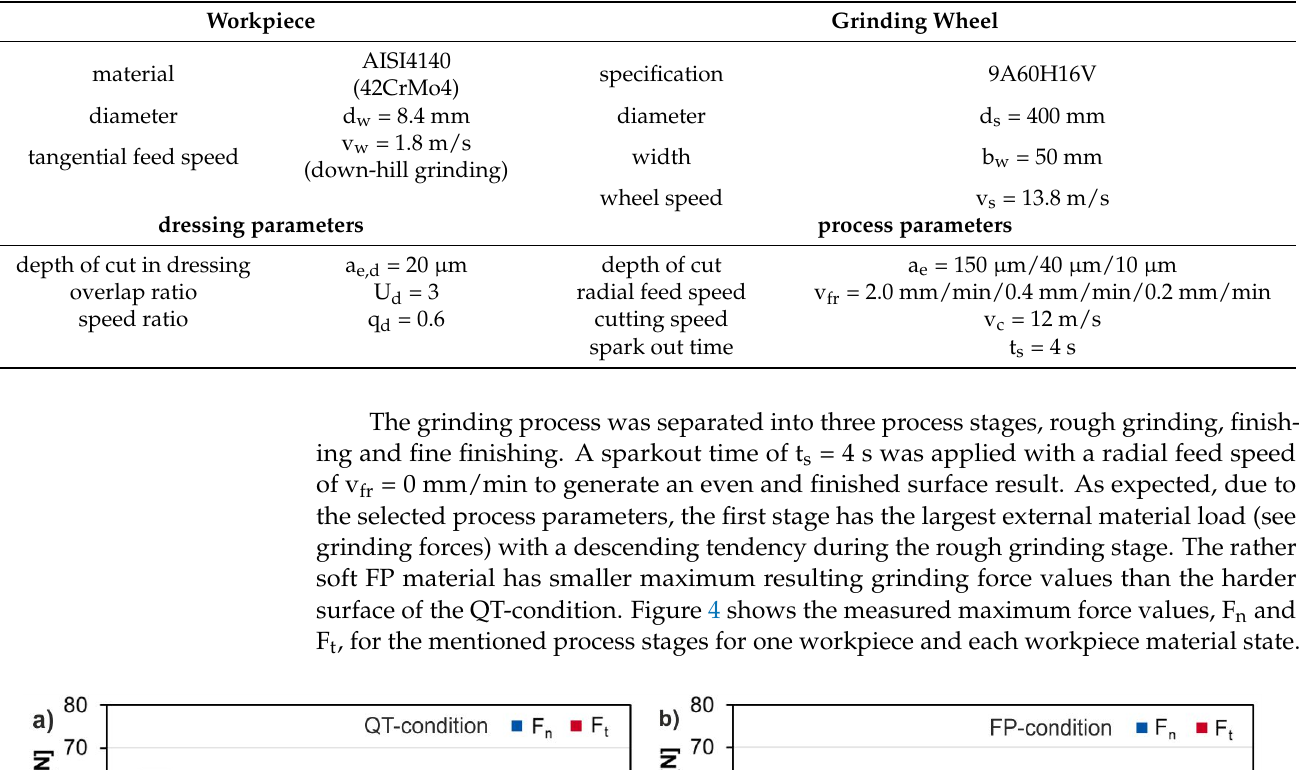
Table 1. Process parameters for the applied grinding process with mechanical main impact.